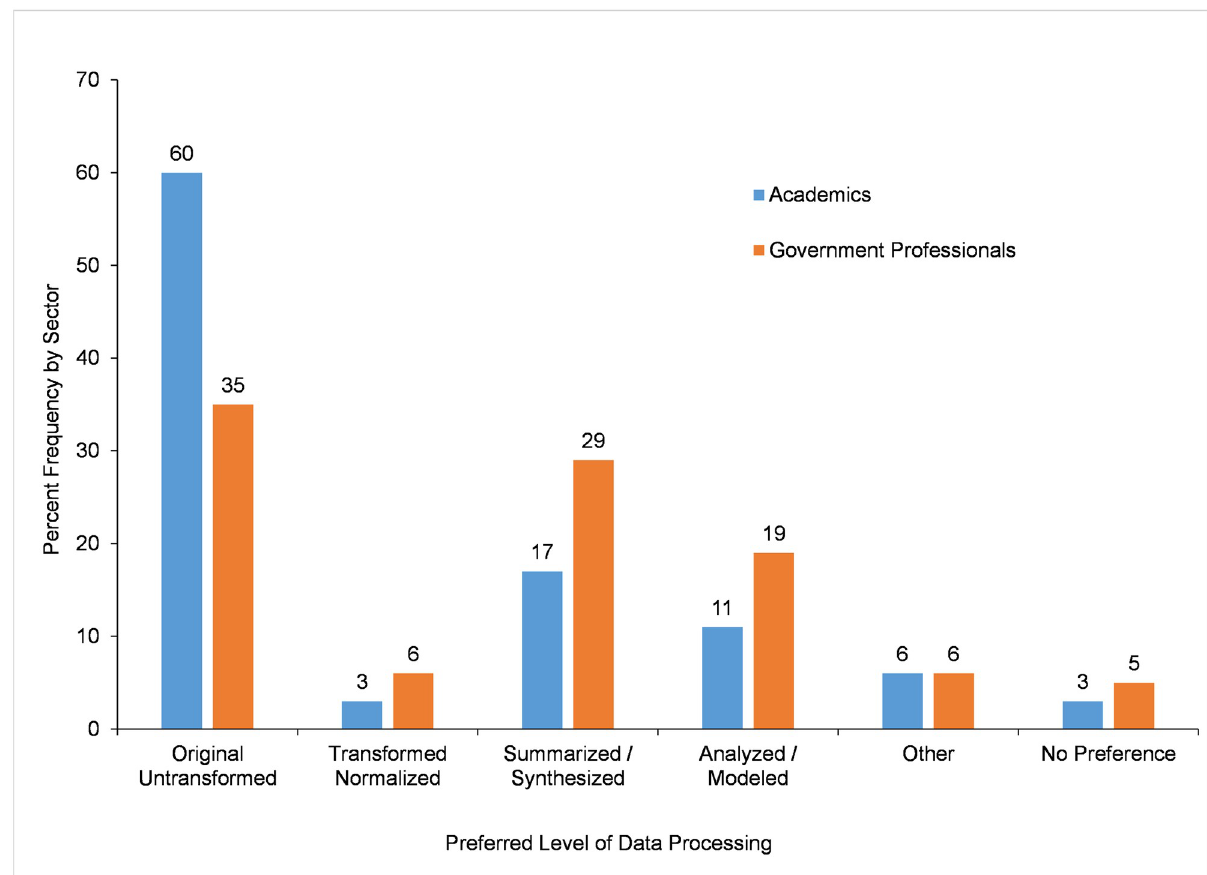
Fig 2. Preferred level of species occurrence data processing for